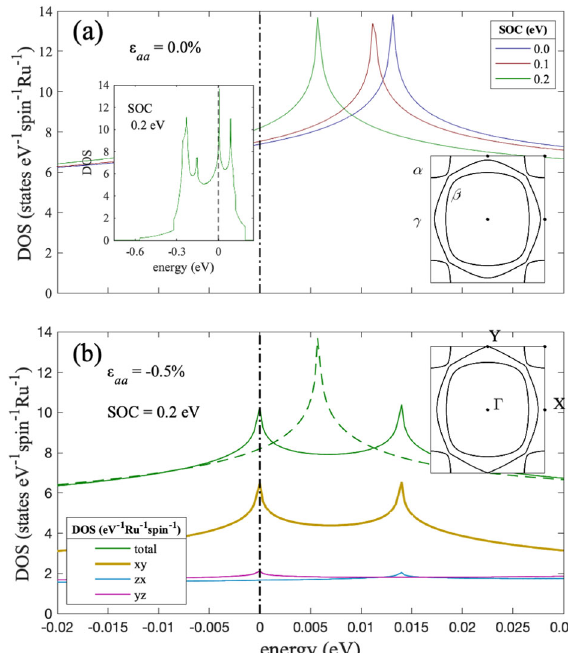
Fig. 2 Effect of strain and spin – orbit coupling on the quasiparticle density of states (QDOS). a The t 2 g (QDOS) as de fi ned in the text. The main panel displays the region around E F while illustrating the in fl uence of the spin – orbit coupling on the location of the van-Hove singularity. The inset shows the QDOS in a broader energy window. The Fermi surface is also shown (right inset). b Decomposition of the QDOS into contributions from the xy , zx , yz orbitals, at the critical strain at which the Fermi energy coincides with the van-Hove singularity. The inset displays the corresponding Fermi